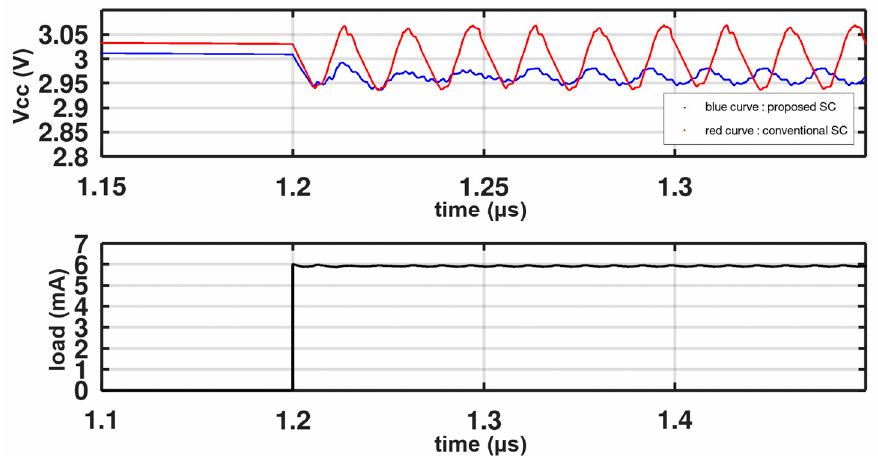
Figure 12. The efficiency of the converter vs. load.